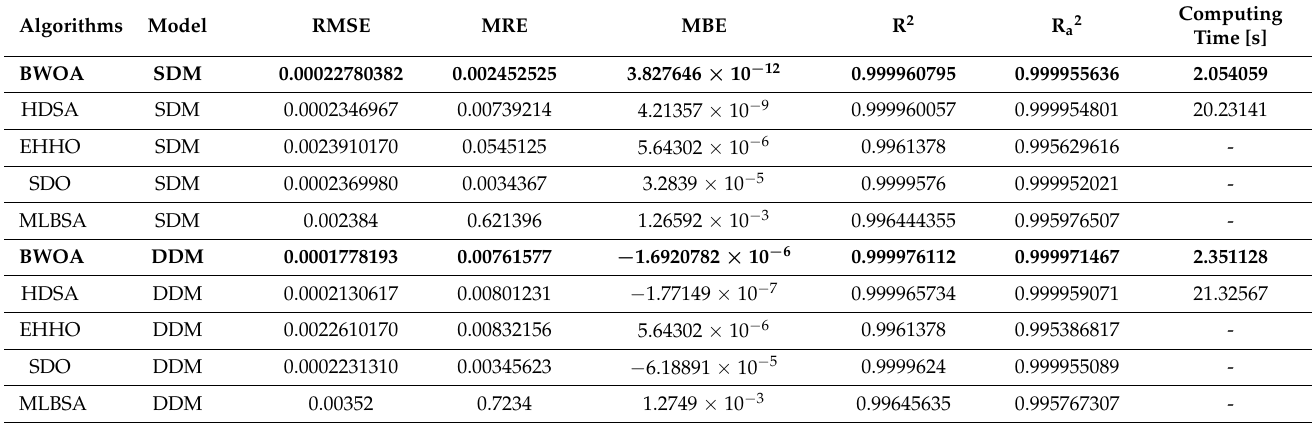
Table 9. Statistical tests of PVM 752 GaAs thin-film photovoltaic panel for different